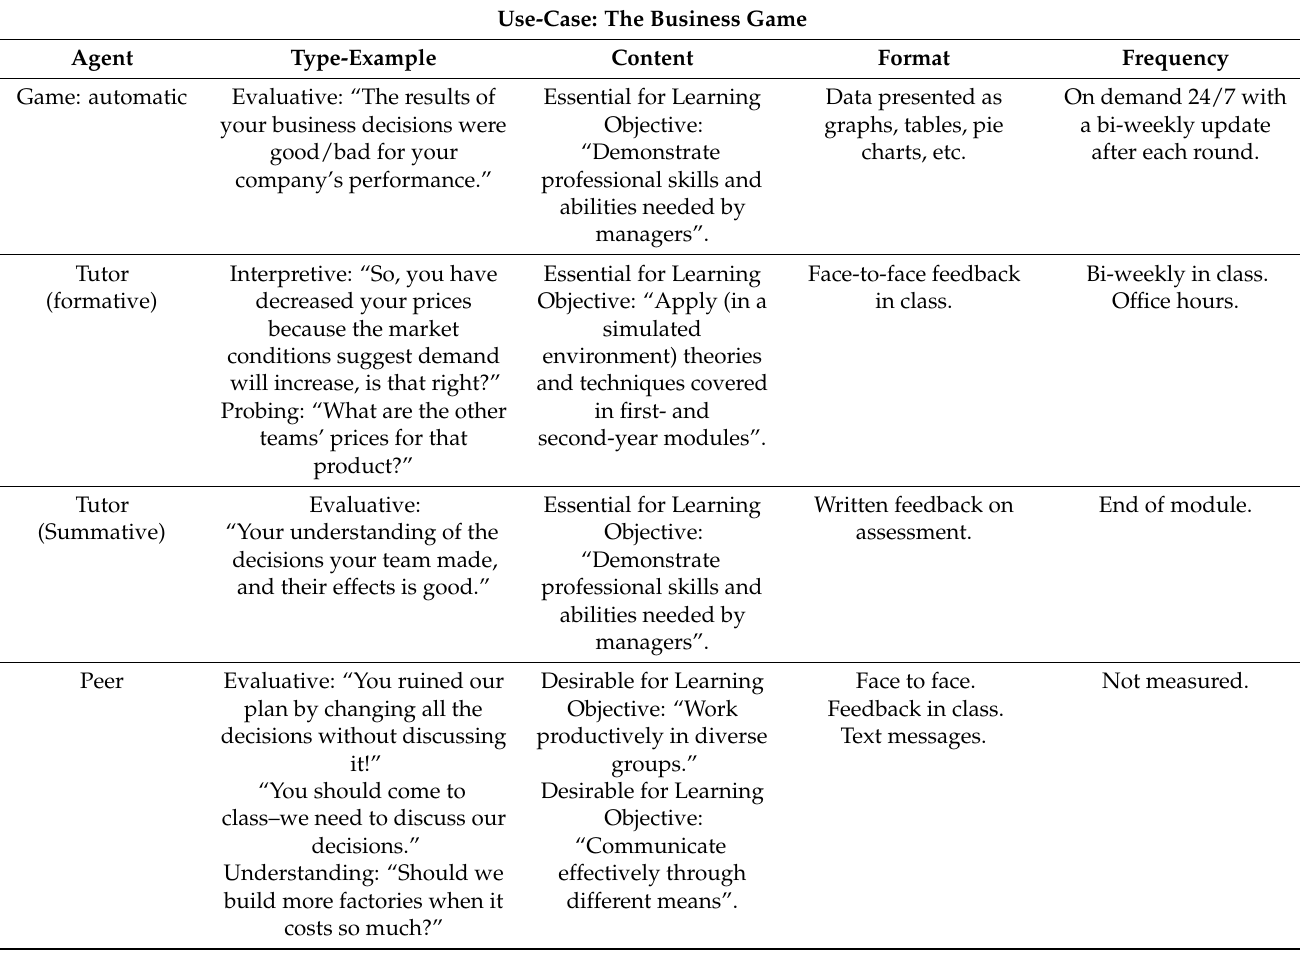
Table 2. The feedback model applied to the market simulation